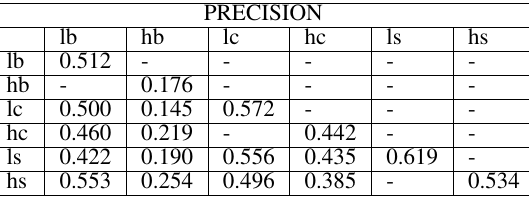
Table 8. Precision values in when using altered images